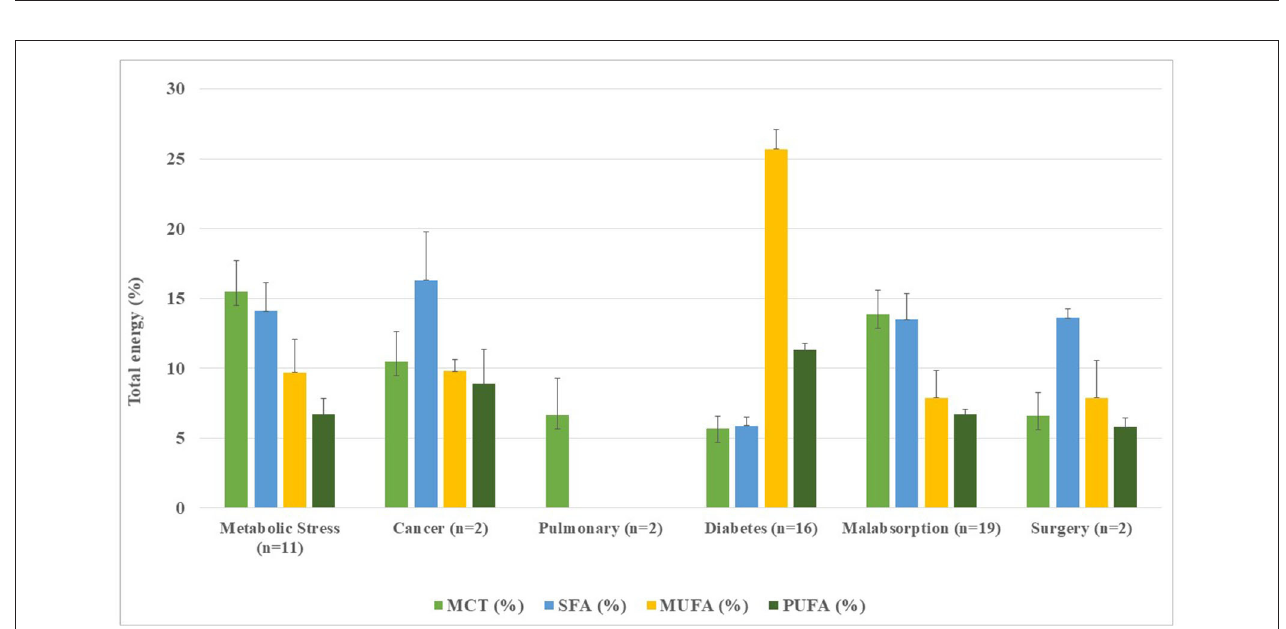
FIGURE 5 | Distribution of fatty acids and medium-chain triglycerides in disease-specific enteral formulae per 1,500 kcal infused.